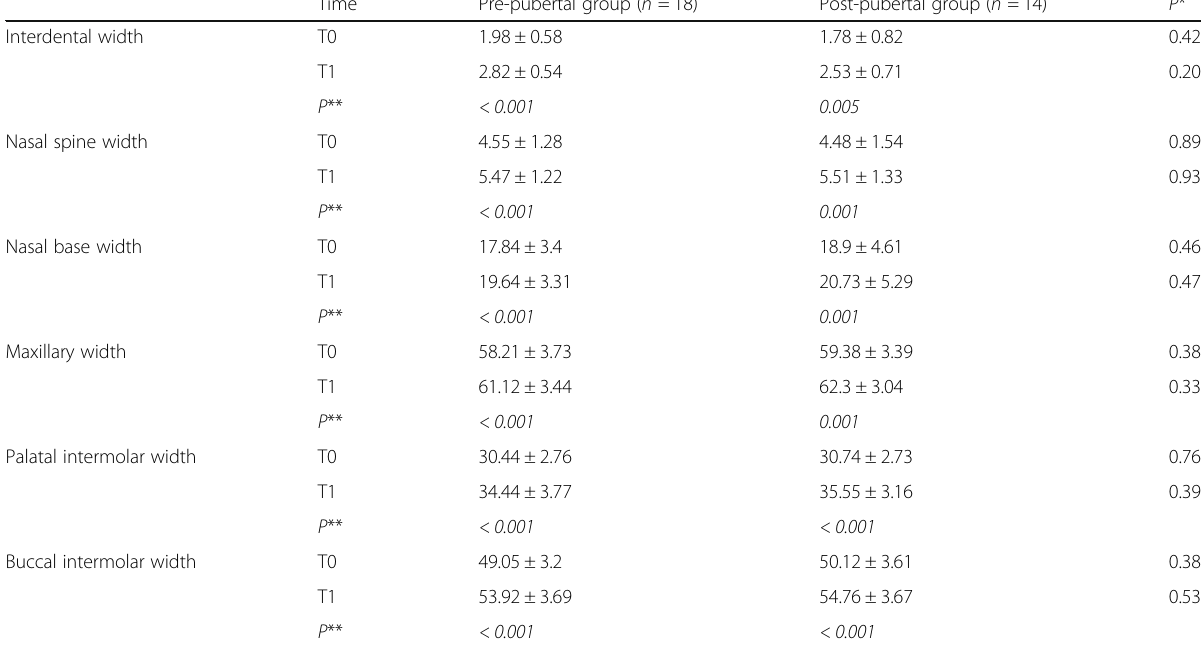
Table 3 Mean differences between the pre-pubertal and post-pubertal groups Time Pre-pubertal group ( n = 18)